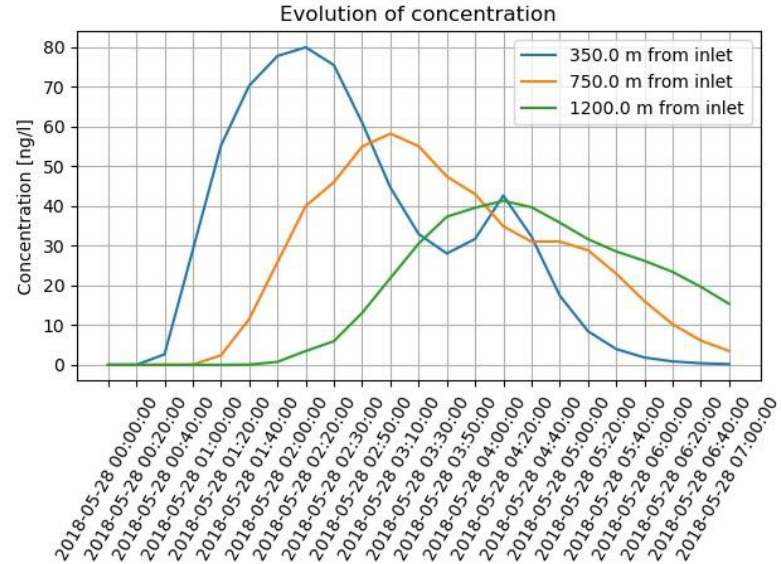
Figure 10. Simulated concentration at x = 400 m, x = 800 m, and x = 1200 m from the inlet point with 20 min time step length.